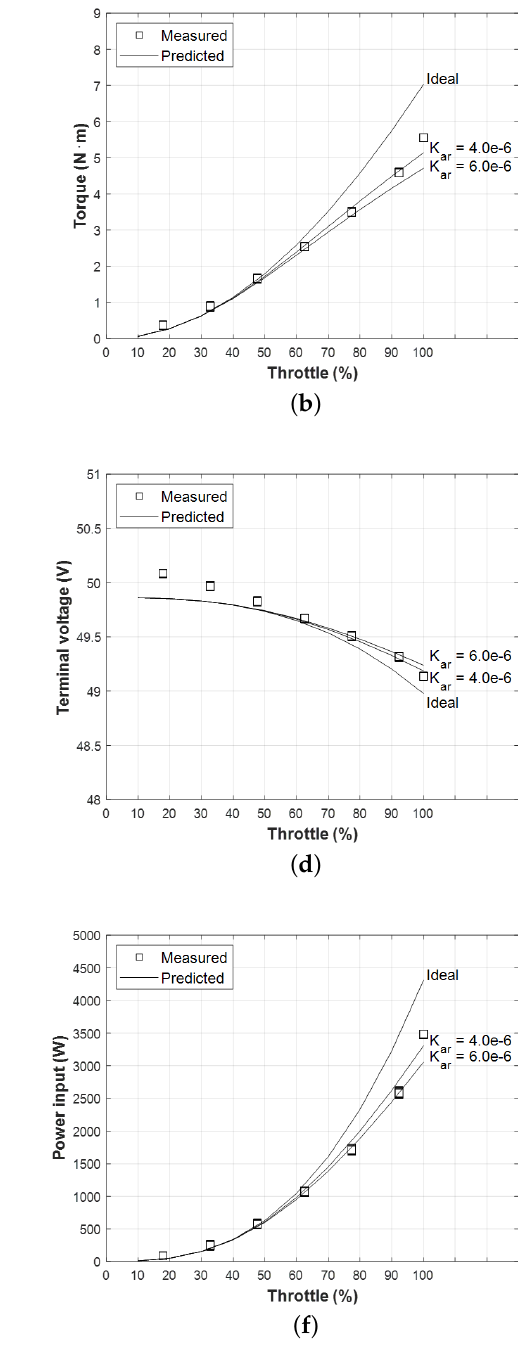
Figure 26. Performance prediction results of sample set 3 (KDE10218XF-105 with KDE-CF-305-DP) compared with static thrust test results: ( a ) Thrust, ( b ) torque, ( c ) rotational speed, ( d ) terminal voltage, ( e ) current consumption, and ( f ) power